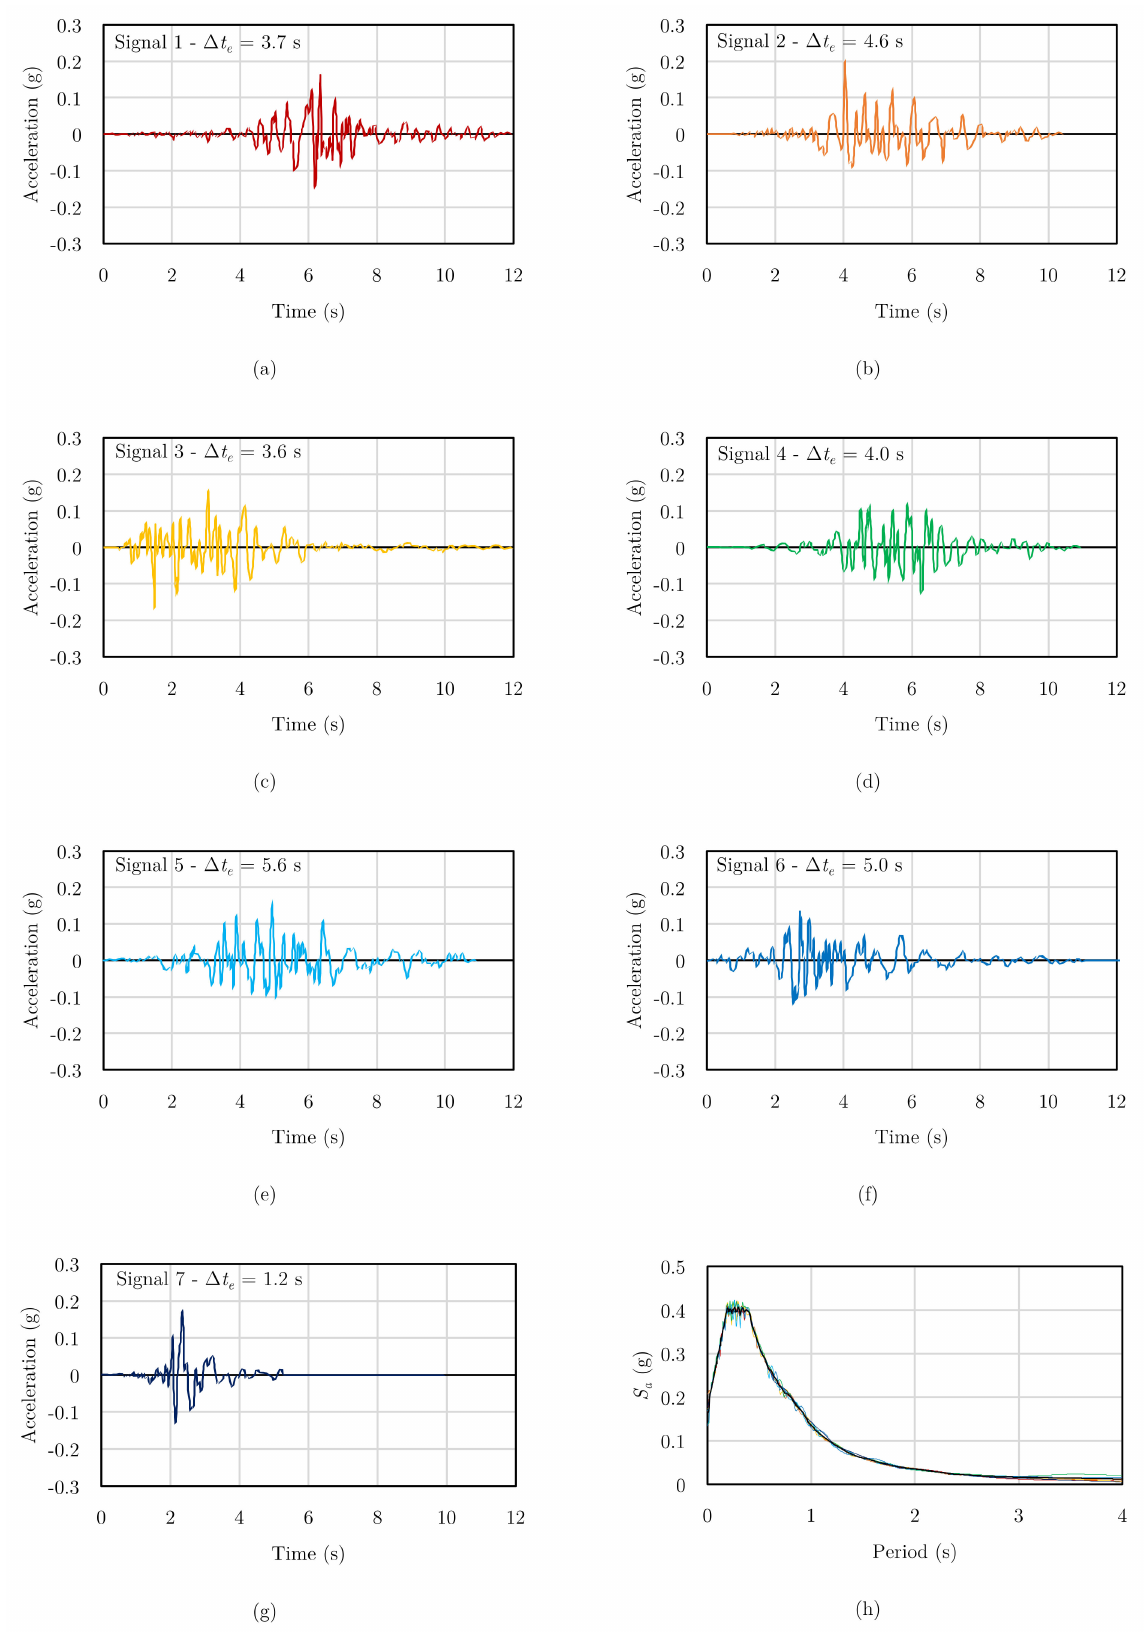
Figure 9. Induced seismic signals ( a – g ) and their average response spectrum ( h , depicted in black) [41,52] adopted for the numerical analyses on buildings B1 and